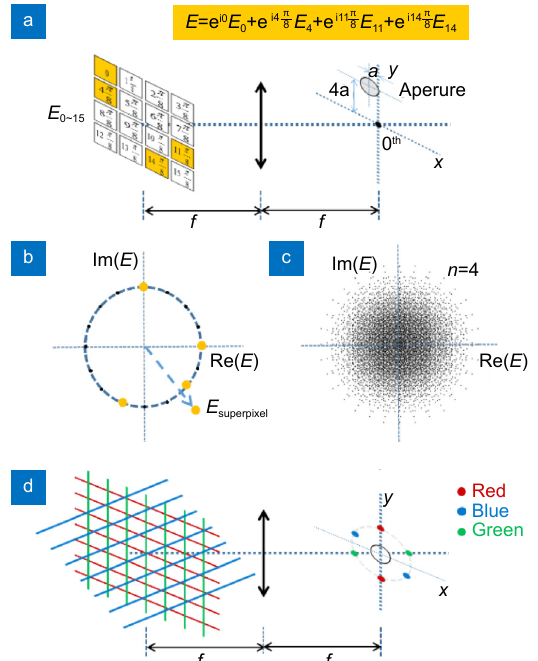
Fig. 1 | Combination of 4×4 neighboring pixels into one super- pixel. ( a ) Weighting phase, where the pixels within each superpixel are distributed uniformly between 0 and 2π, each pixel can be inde- pendently modulated, and a spatial filter in the form of a circular aperture is placed in the Fourier plane of the first lens. We turn on the four pixels indicated by the yellow squares as an example. ( b ) The response E is the sum of the modulated pixels, as represented by the line arrow. ( c ) Complex target fields that can be constructed using a single super-pixel with size of 4×4, where the number of fields that can be constructed is 49291, the horizontal axis is the real part and the vertical axis is the imaginary part. ( d ) By loading blazed gratings in different directions for different colors of light, splitting of the differently colored light on the Fourier focal plane can be